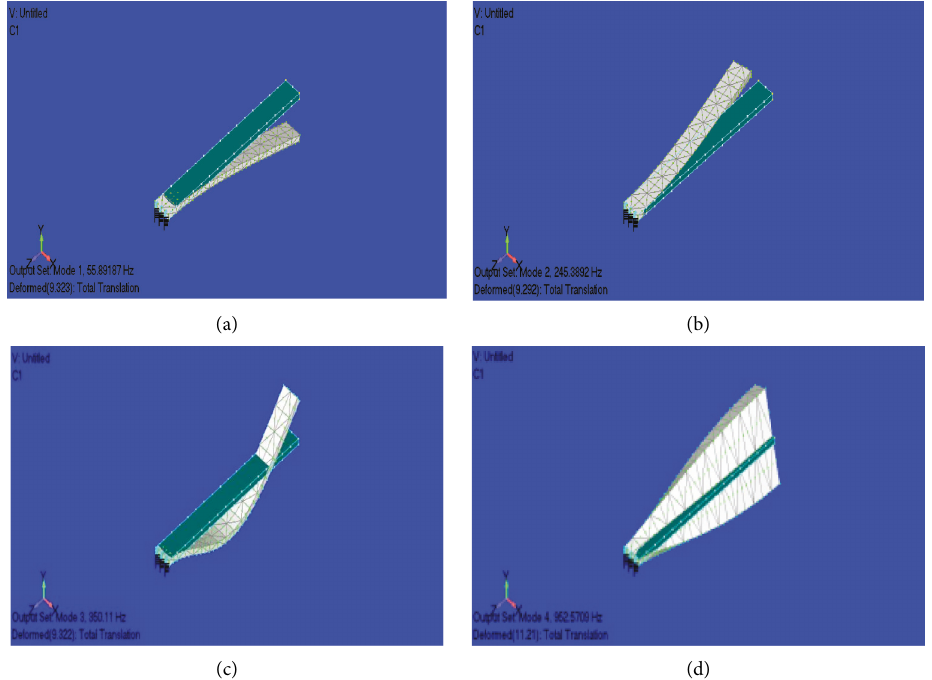
Figure 13: Vibration analysis of the 70/30% glass/epoxy composite plate. (a) Mode 1, (b) Mode 2, (c) Mode 3, (d) Mode